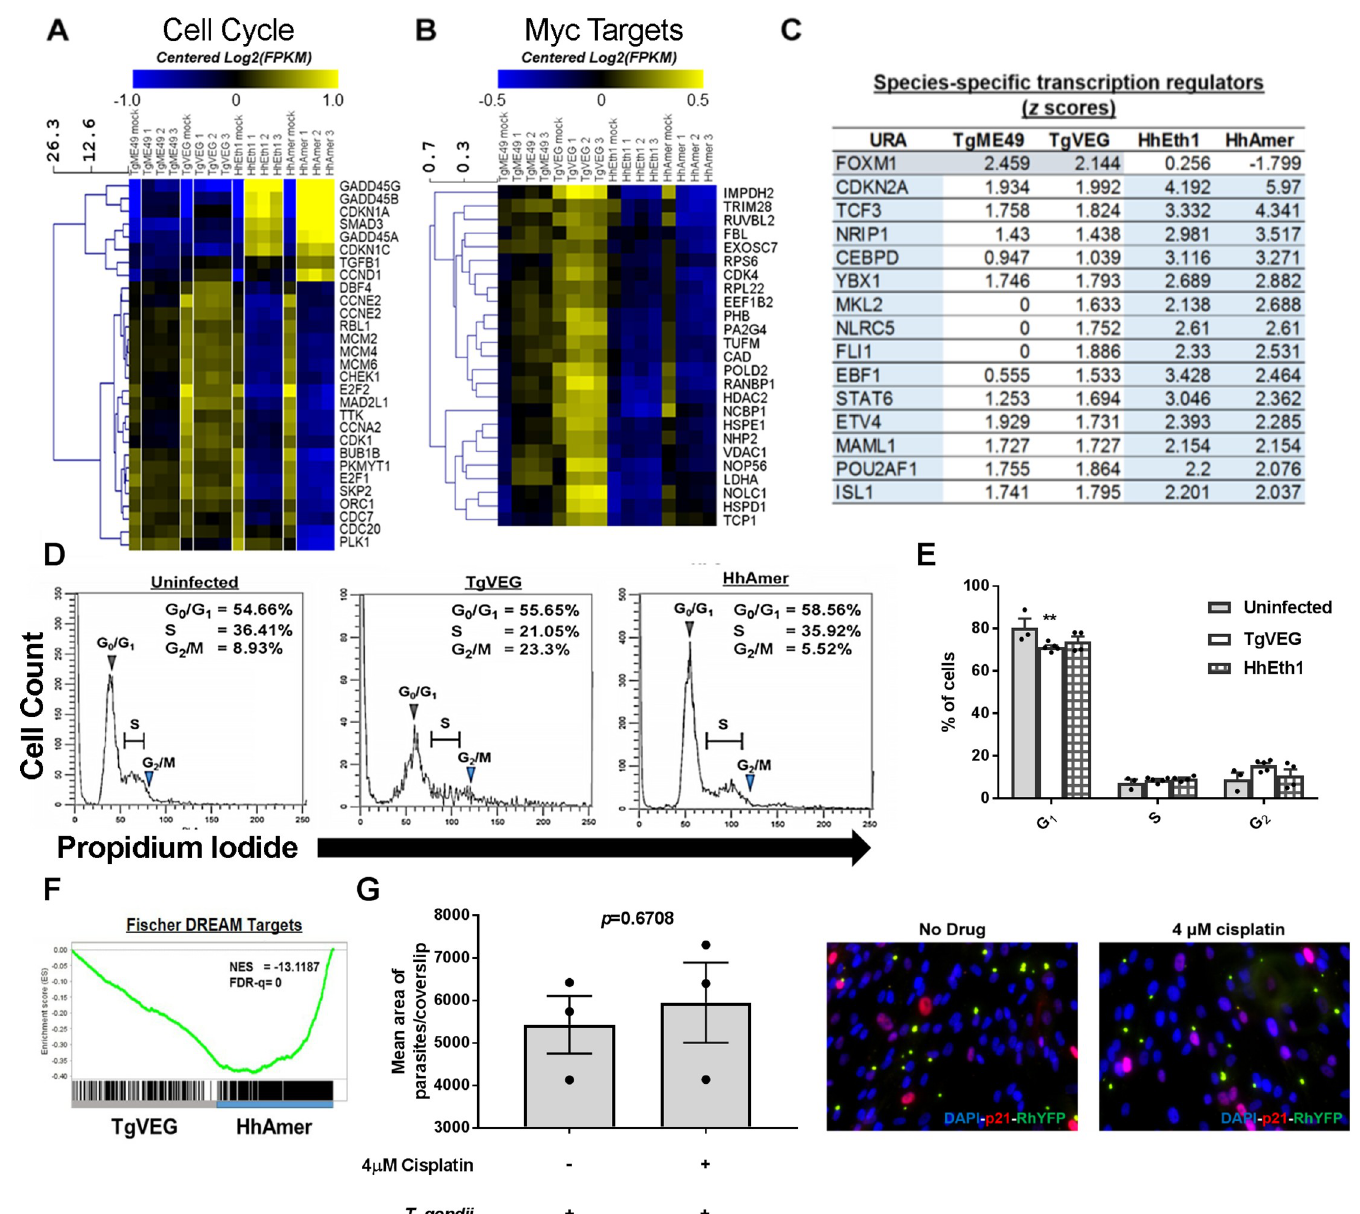
Fig 4. H . hammondi infection of THP-1 cells leads to a dramatically different impact on cell cycle regulation pathways. (A, B) Heatmaps showing log 2 transcript abundance for genes belonging to either the Cell cycle (A) or Myc targets v1 (B) gene set across strain and species. Log 2 normalized data were mean-centered amongst the samples and hierarchically clustered (Euclidean distance). (C) Table showing z scores of upstream transcriptional regulators predicted to be activated ( z scores � 2) and/or inhibited ( z scores � -2; T . gondii —grey; H . hammondi –light blue) in a species-specific manner. (D) THP-1 cells were infected with T . gondii (TgVEG), H . hammondi (HhAmer) or mock-treated for 20 hours and fixed with 80% ethanol. THP-1 cells were then stained with propidium iodide (PI) and DNA content was analyzed with flow cytometry. Cell cycle progression was analyzed with ModFitLT software. Black lines represent histograms of DNA content (PI-Area) vs. cell counts. Grey arrows show the G 0 /G 1 peaks and blue arrows mark the G 2 /M peak. Areas of the histogram in between the G 0 /G 1 and the G 2 /M peaks contain host cells in the S phase. TgVEG-infected THP-1 cells displayed higher portions of cells found at the G 2 /M phase as compared to HhAmer-infected cells. (E) Cell cycle progression in U2OS cells infected with an MOI of 2 of T . gondii (TgVEG) or H . hammondi (HhEth1) was analyzed with propidium iodide (PI) staining and flow cytometry. Percentages of cells in each stage were determined with FlowJo and statistically compared using one way ANOVA followed by Tukey’s post-hoc test. Only T . gondii VEG-infected, and not H . hammondi American-infected, cells had a lower percentage of cells in G0/G1 compared to mock-infected cells ( �� P < 0.01). (F) Fisher DREAM Targets gene set enrichment in H . hammondi -infected cells compared to T . gondii -infected cells. (G) Growth of T . gondii Rh-YFP on HFFs in cells treated with cisplatin to induce p21 expression (p21 levels were quantified using immunofluorescence and shown in S4C Fig). HFFs were treated with 4 μ M of cisplatin or vehicle for 24 h followed by infection with T . gondii Rh-YFP (MOI = 0.1). T . gondii Rh-YFP was allowed to grow for 24 h before analyzing growth of the parasites by immunofluorescence (IFA). Numbers of T . gondii RH-YFP parasites were not significantly different in cisplatin-treated HFFs as compared to mock-treated HFFs (unpaired t- test, p = 0.67).